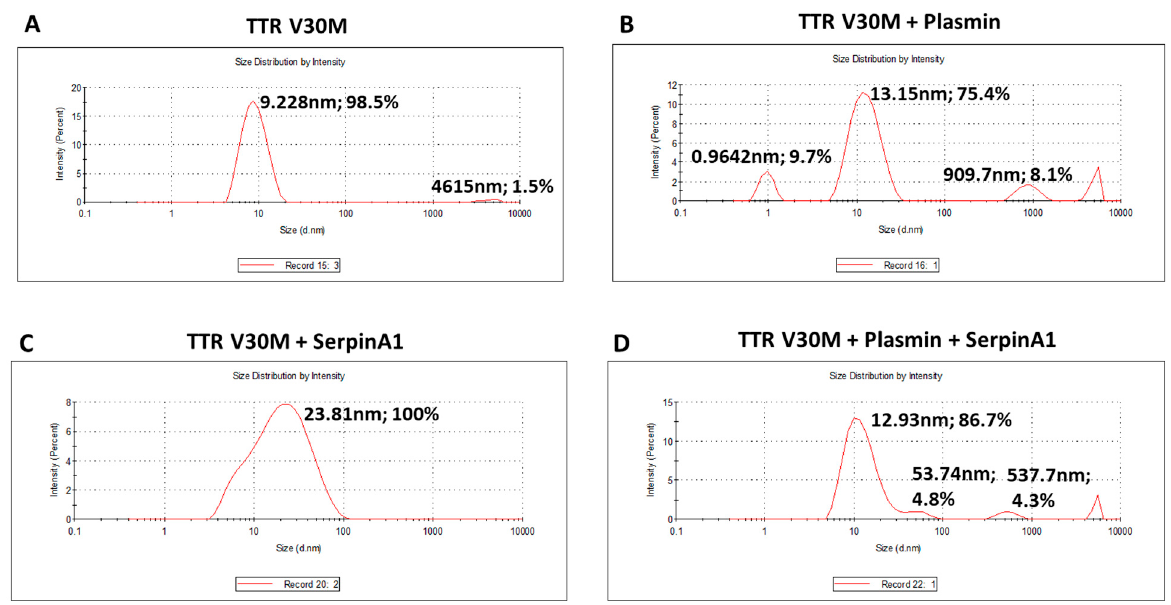
Figure 2. Plasmin enhances the transthyretin V30M aggregation, while SerpinA1 inhibits the process. Dynamic light scattering analysis was performed upon transthyretin V30M incubation at 37 °C for 24 h: ( A ) alone; ( B ) with plasmin; ( C ) with SerpinA1; ( D ) with plasmin and SerpinA1. The data results from three independent in vitro experiments, each one performed in triplicate.